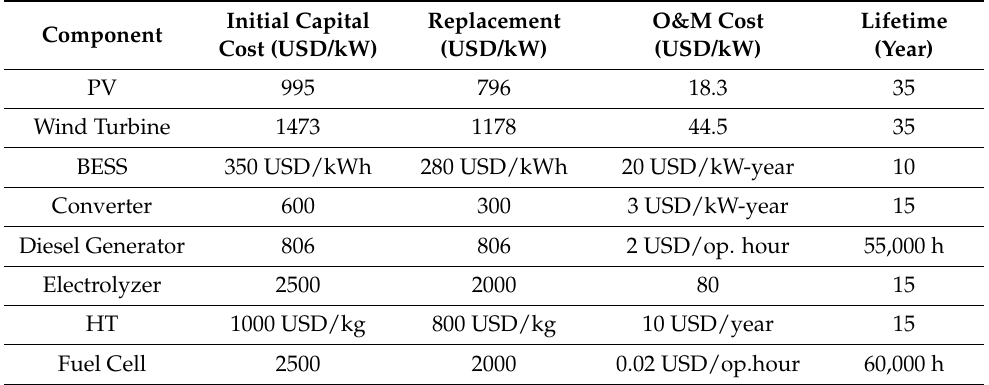
Table 4. Summary of major component inputs.